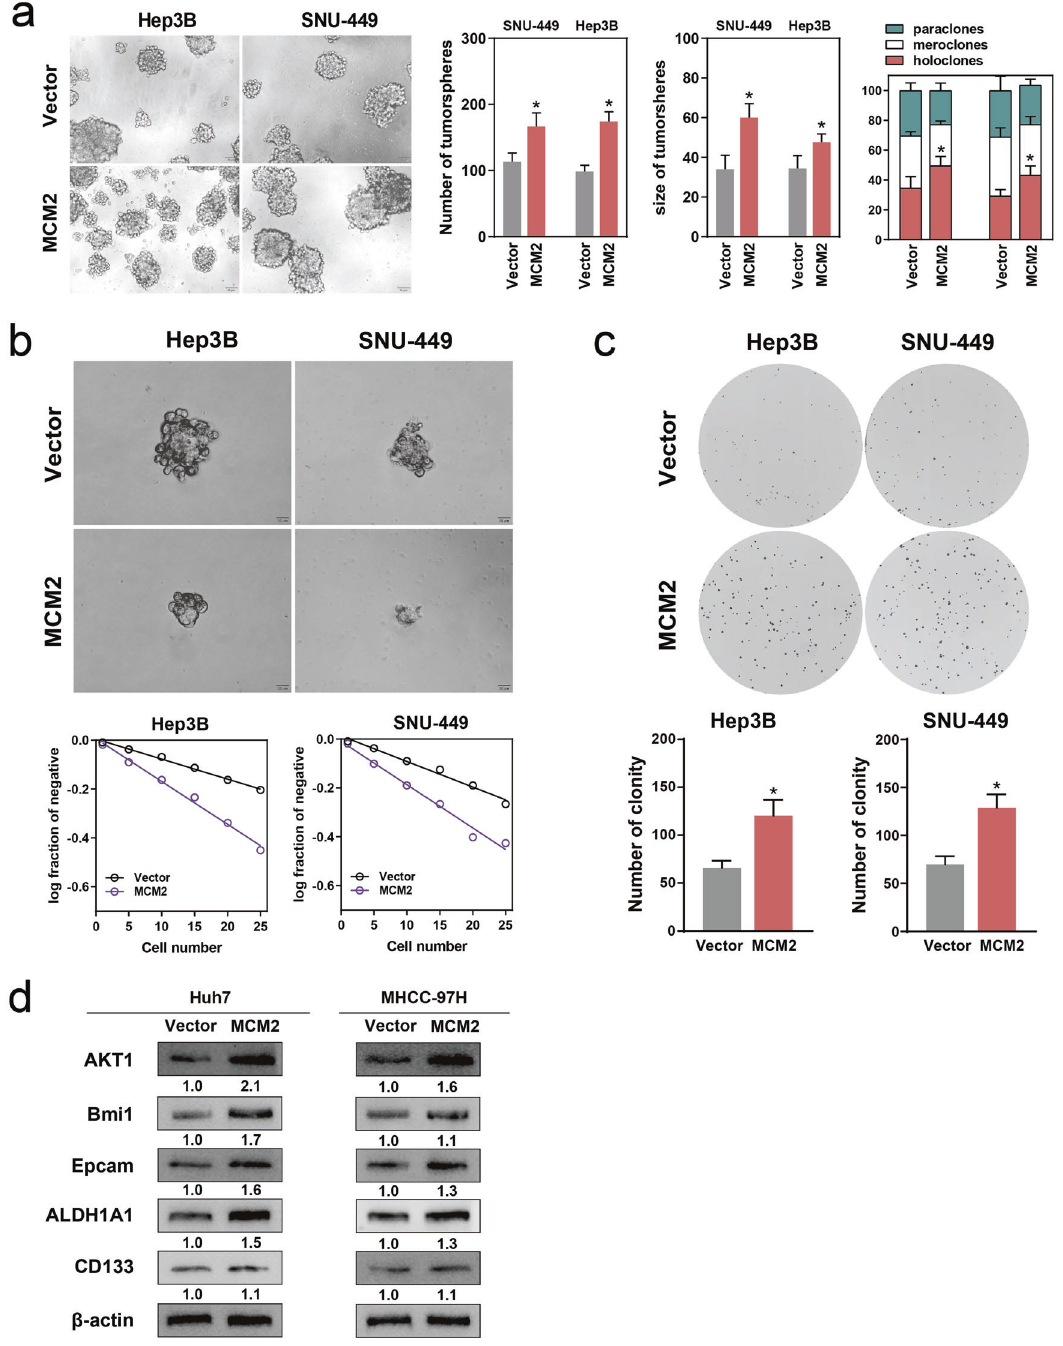
Fig. 3 The up-regulation of MCM2 enhanced the stemness of HCC cells. a Representative images of tumor-spheres in the MCM2 over- expression and control groups of the indicated cells, corresponding histogram and corresponding sphere morphology percentage chart. b Representative images of tumor-spheres formation in the limiting dilution assays of the indicated cells and the log-dose slope of the MCM2 over-expression and control groups. c Representative images of colony in the MCM2 over-expression and control groups of the indicated cells and corresponding histogram; d The immunoblotting for Bmi1, AKT1, CD133, ALDH1A1 and Epcam expression in the Vector and MCM2 groups of the indicated cells, determined by Western Blot assay; Data are shown as the mean ± SD from independent experiments. * P < histograms are shown in Fig. S2d. Limitation dilution assays were conducted to evaluate the self-renewal ability and stemness of the cells.